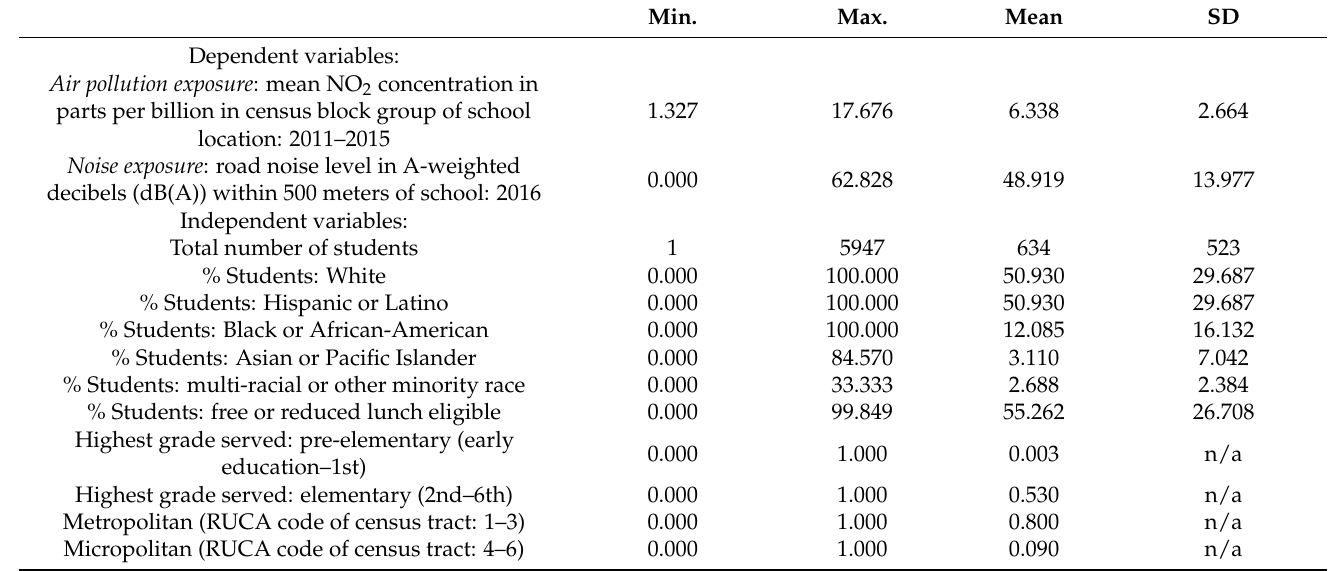
Table 1. Summary statistics for variables analyzed. Min.